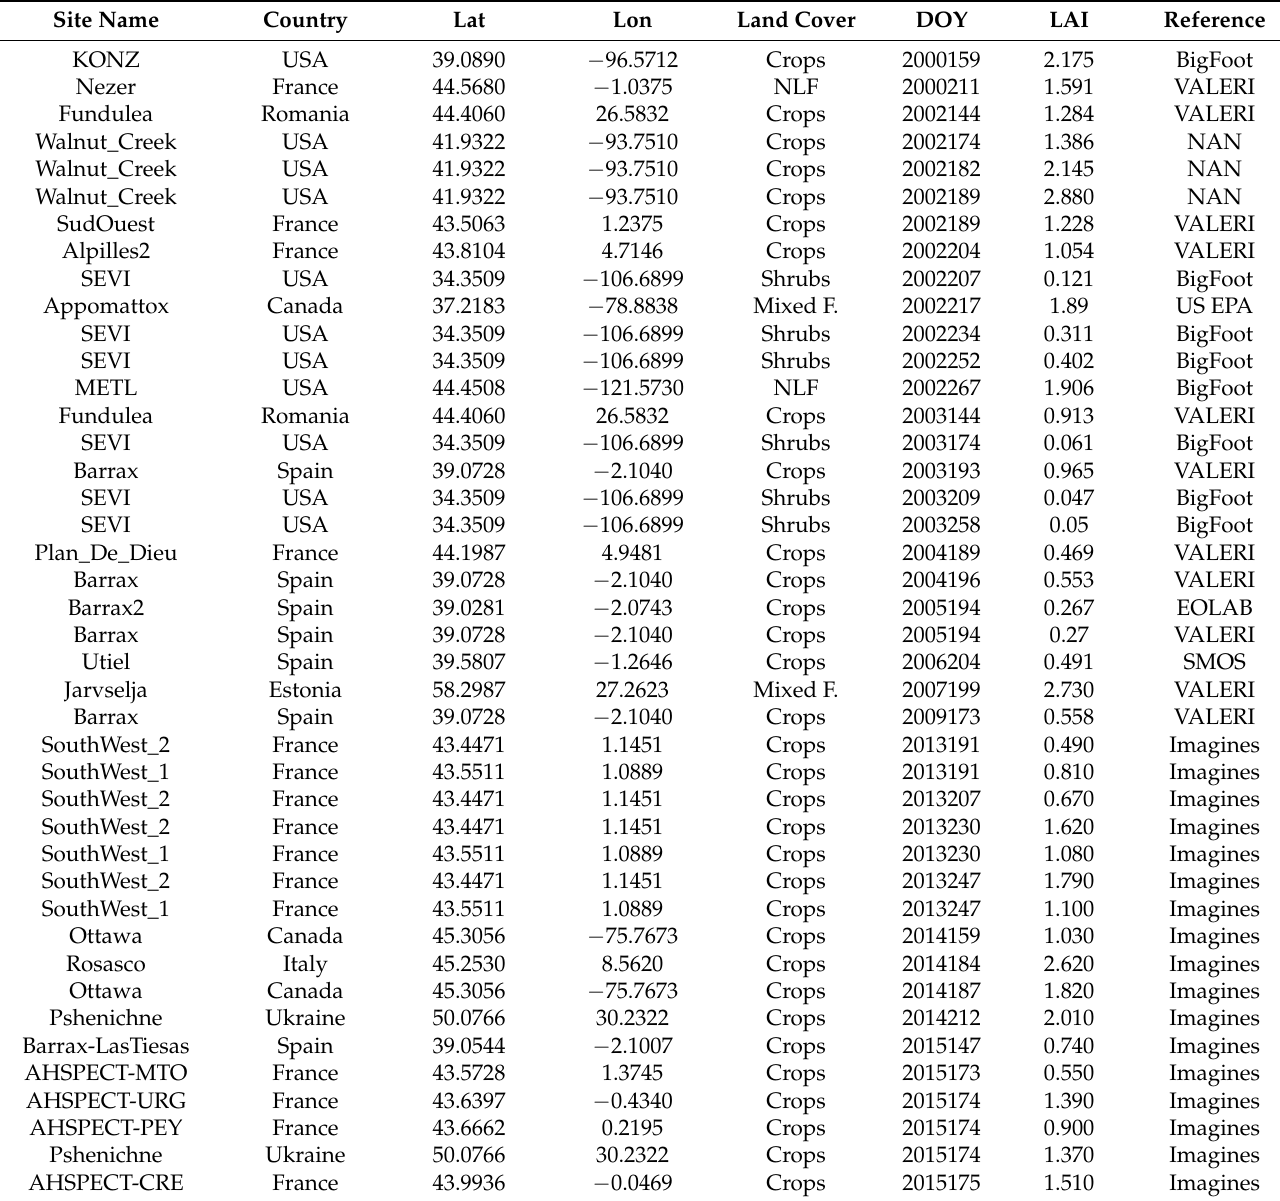
Table 1. Information of the selected